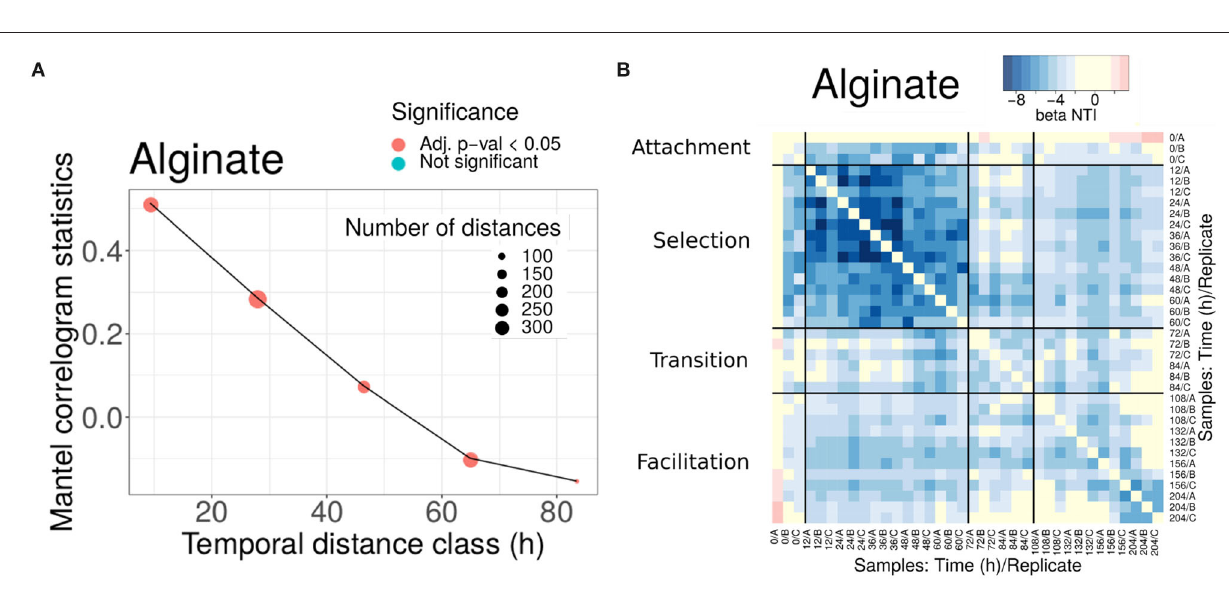
FIGURE 3 | Phylogenetic turnover for experiments in alginate. (A) Mantel statistics indicating the correlation between the phylogenetic and time distances in beads of alginate. Both matrices are split into subsets corresponding to different ranges of distances, and an independent test performed for each subset. The middle point of each range is indicated in the x-axis, and the number of distances in each subset and the significance of each test are shown in the legend. For alginate, all comparisons were significant. (B) All-against-all comparison of the β NTI index (excluding diagonal values). The black thicker lines separate comparisons within and between the different phases. Significant values correspond to | β NTI|>2, non-significant values are shown in yellow. Results for other substrates are provided in the Supplementary Material